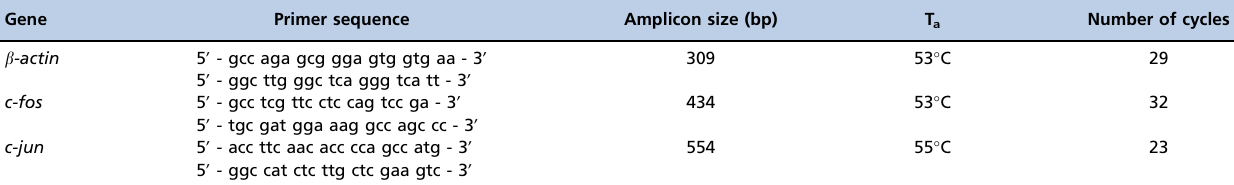
Table 1 - Primer sequences and amplification